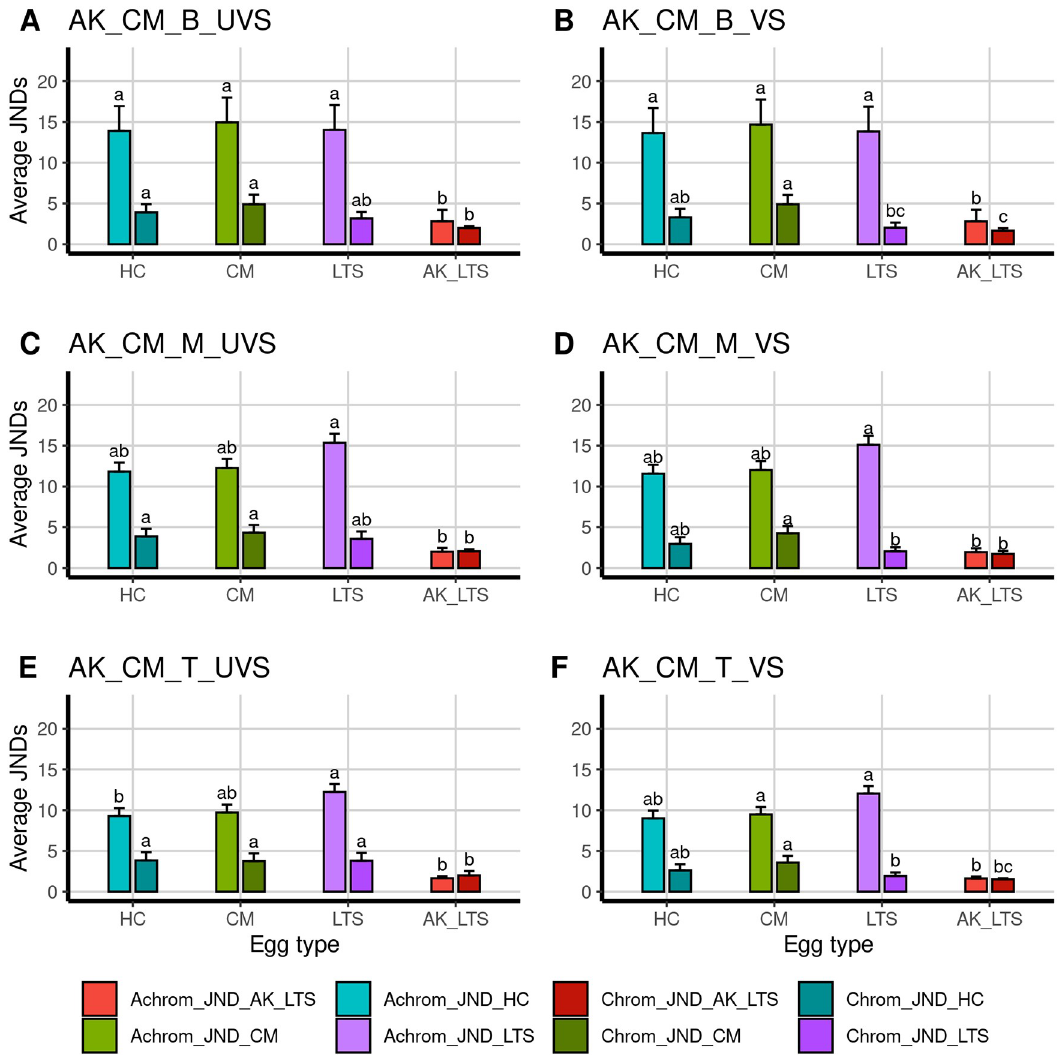
Fig 4. Average achromatic and chromatic JNDs ± SD between Asian koel eggs laid in common myna nests (AK_CM) compared to three hosts: The house crow (HC), the common myna (CM) and the long-tailed shrike (LTS) and the eggs of the Asian koel laid in long-tailed shrike nests (AK_LTS). Achromatic (Achrom_JND) and chromatic (Chrom_JND) analyses were performed for egg regions (B = blunt, M = middle, T = top) and visual system (UVS = ultraviolet-sensitive, VS = violet-sensitive) separately. Letters above columns denote significant differences (Dunn post-hoc test, p < 0.05 after correcting for multiple tests following Benjamini and Hochberg 1995 [94], see S4